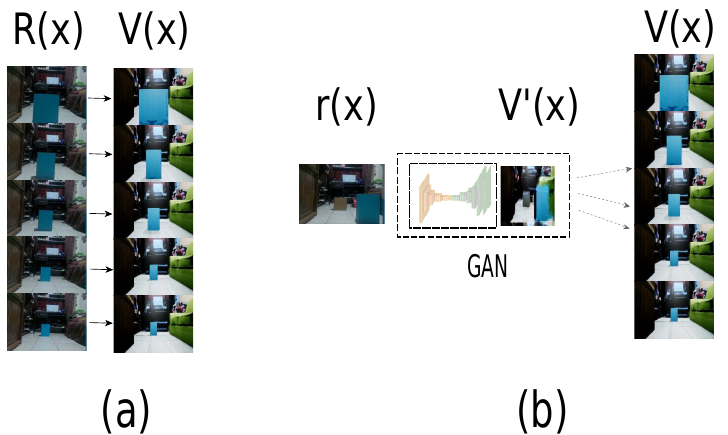
Figure 4. Domain connection approach. ( a ) Connection one-to-one. ( b ) Connected domains by a GAN.